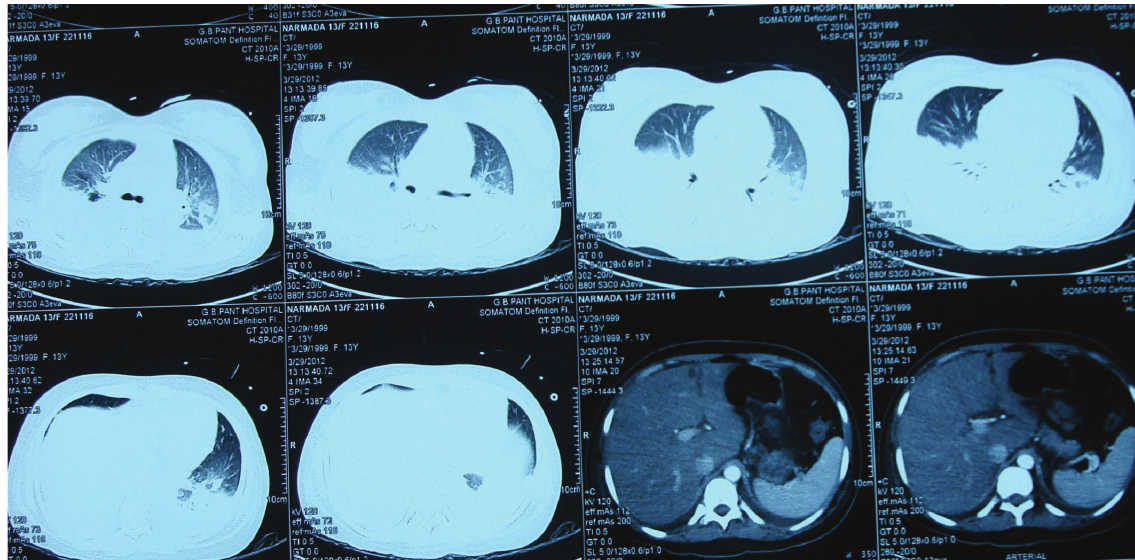
Figure 3: CT sections showing bilateral pleural effusion with atelectatic lower